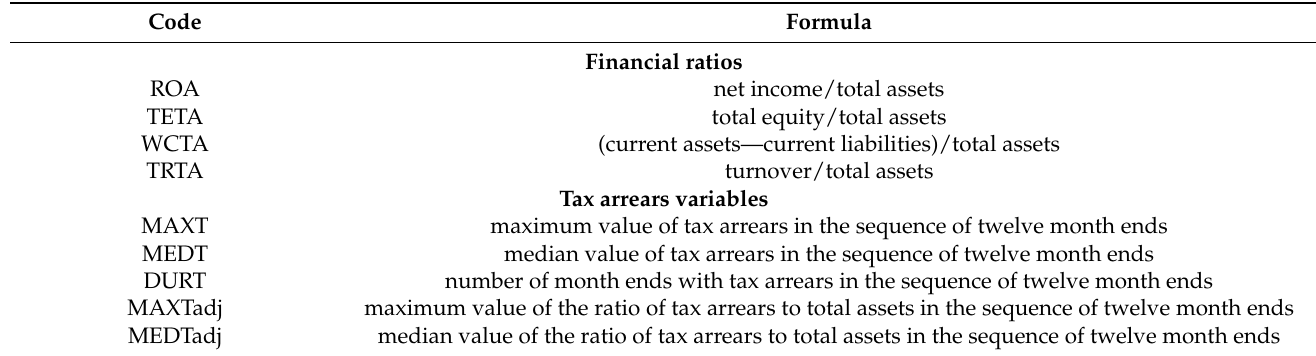
Table 2. Variables applied in this